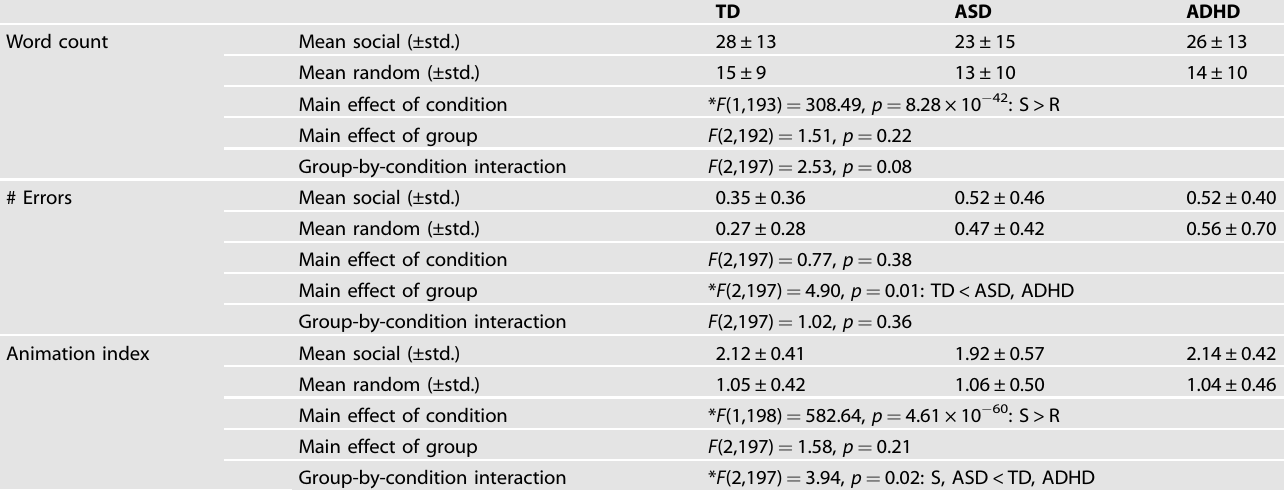
Table 2. Means and standard deviations for the task behavioural measures (word count, number of errors, and animation index) for the TD, ASD, and ADHD participants, along with statistical results from repeated-measure ANOVAs examining main effects of the condition, group, and their